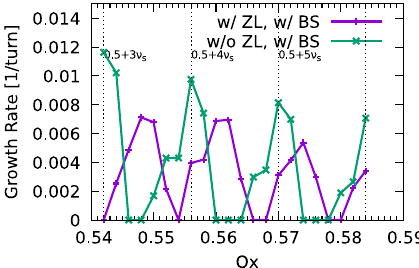
FIG. 5. The horizontal beam size growth rate versus horizontal tune with and without beamstrahlung effect (BS). The stable equilibrium bunch length and energy spread is same between the two cases, where σ z; and σ p; are tuned in latter SR SR